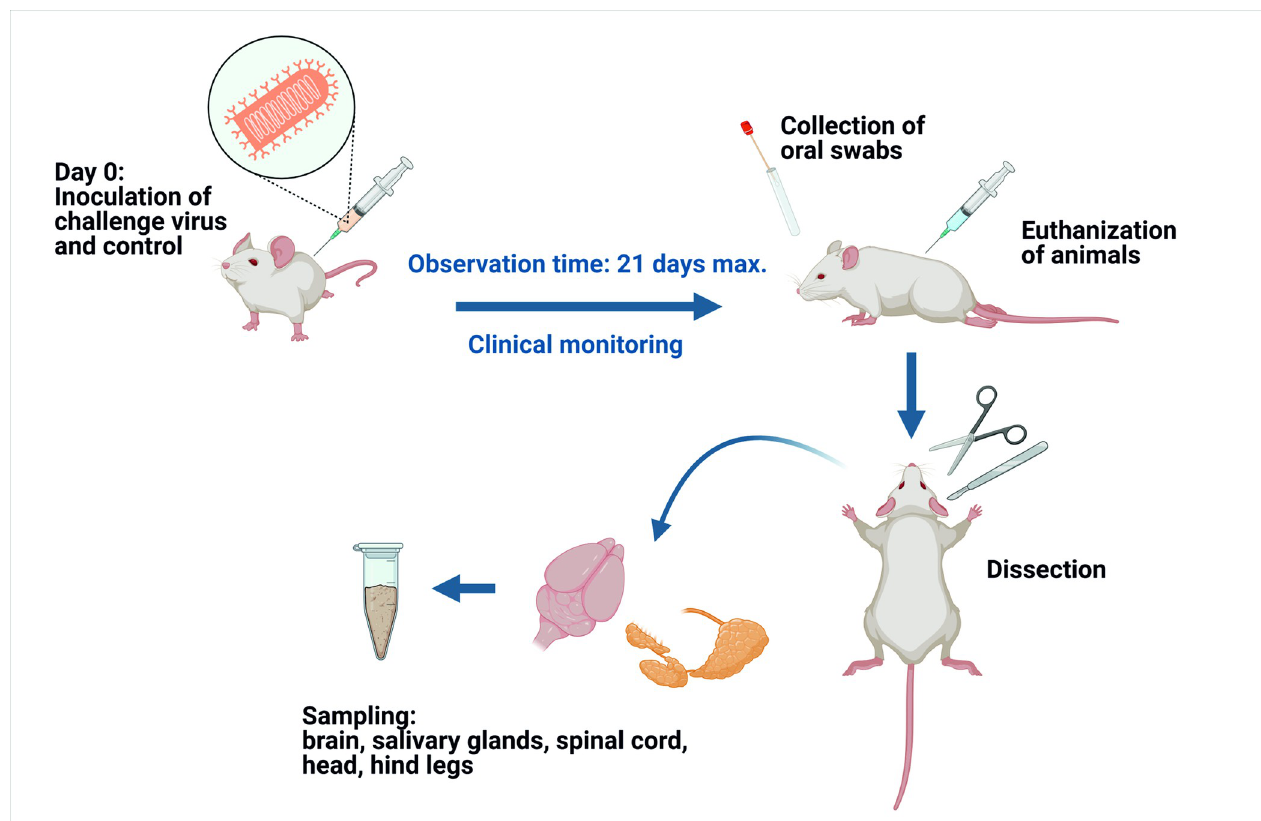
Fig 2. Experimental setup. Outline of the animal experiment and sample